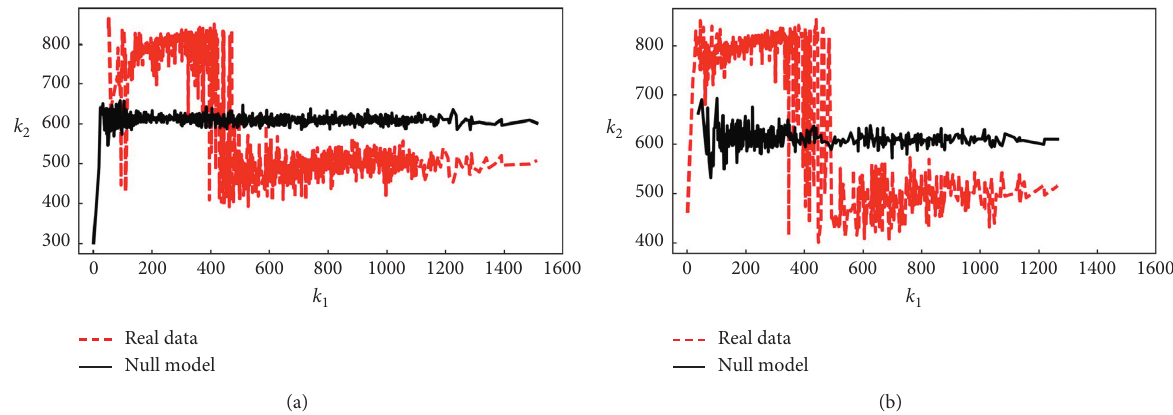
Figure 1: Degree correlation for (a) real-world network and (b) null model network.